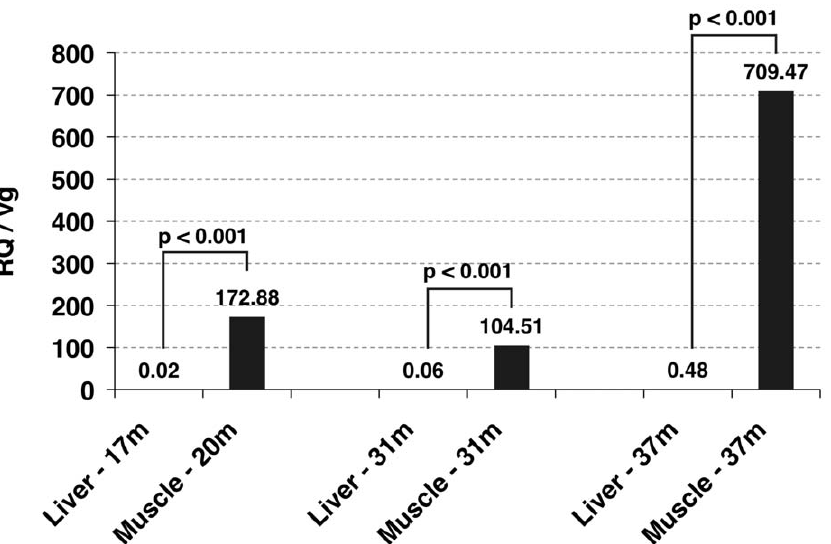
Figure 5. Differential transgene expression level in Mac 9 skeletal muscle and liver. mRNA relative quantities (RQ) were determined at the indicated time points by quantitative RT-PCR using WPRE as target rAAV sequence and HPRT as endogenous macaque reference, and the equation relating these: RQ=2 2 (Ct WPRE – Ct HPRT) . Data are expressed relative to the vector genome copy number (vg) determined by Q-PCR using LEA29Y as target and e -globin macaque gene as endogenous.